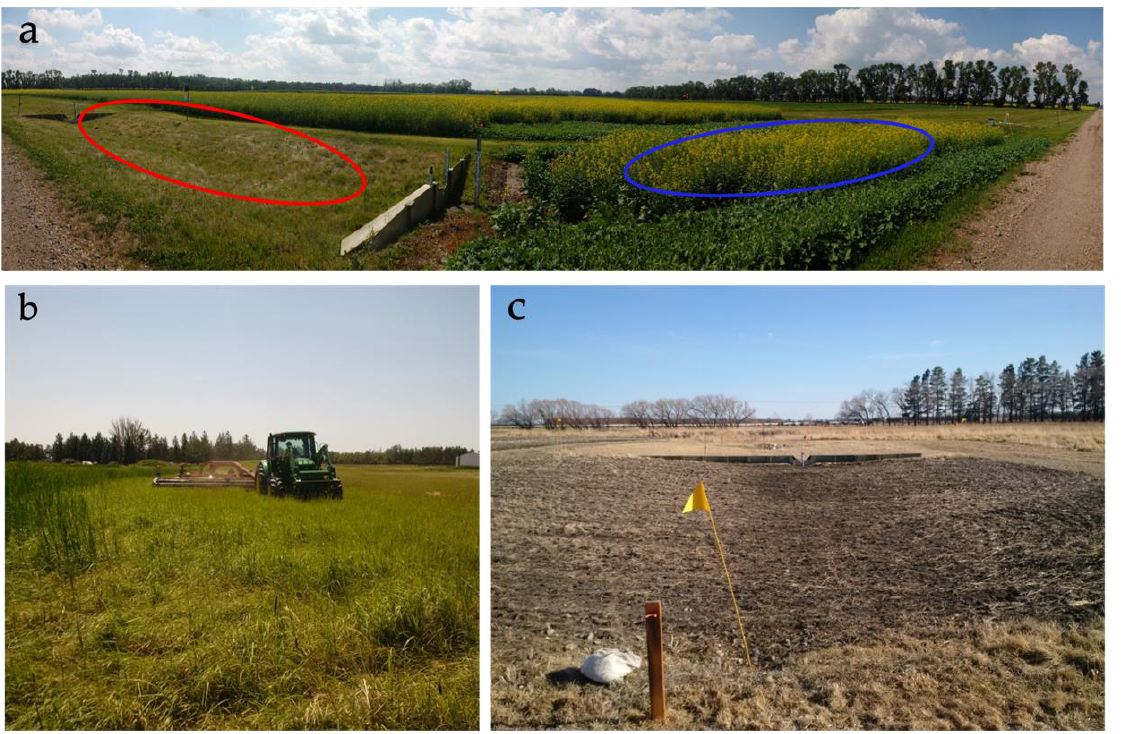
Figure 2. ( a ) Panoramic image that shows residue at VFS2 after it has been harvested (red) and C2 with harvestable vegetation intact (blue); ( b ) image depicting both harvestable vegetation and residue at VFS2 and the equipment used to remove vegetation; and ( c ) image depicting what was sampled as spring residue at VFS3 (foreground) and at C3 (behind weir).